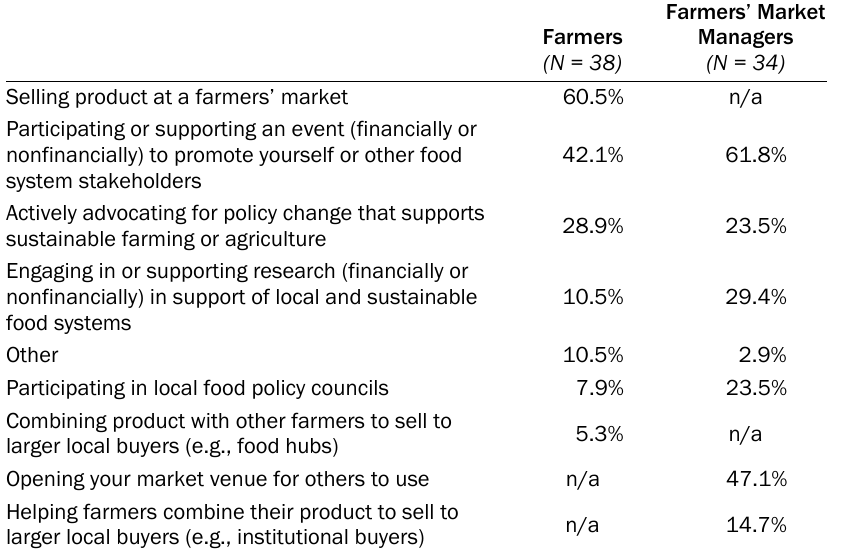
Table 3. Participation in Collaborative Initiatives